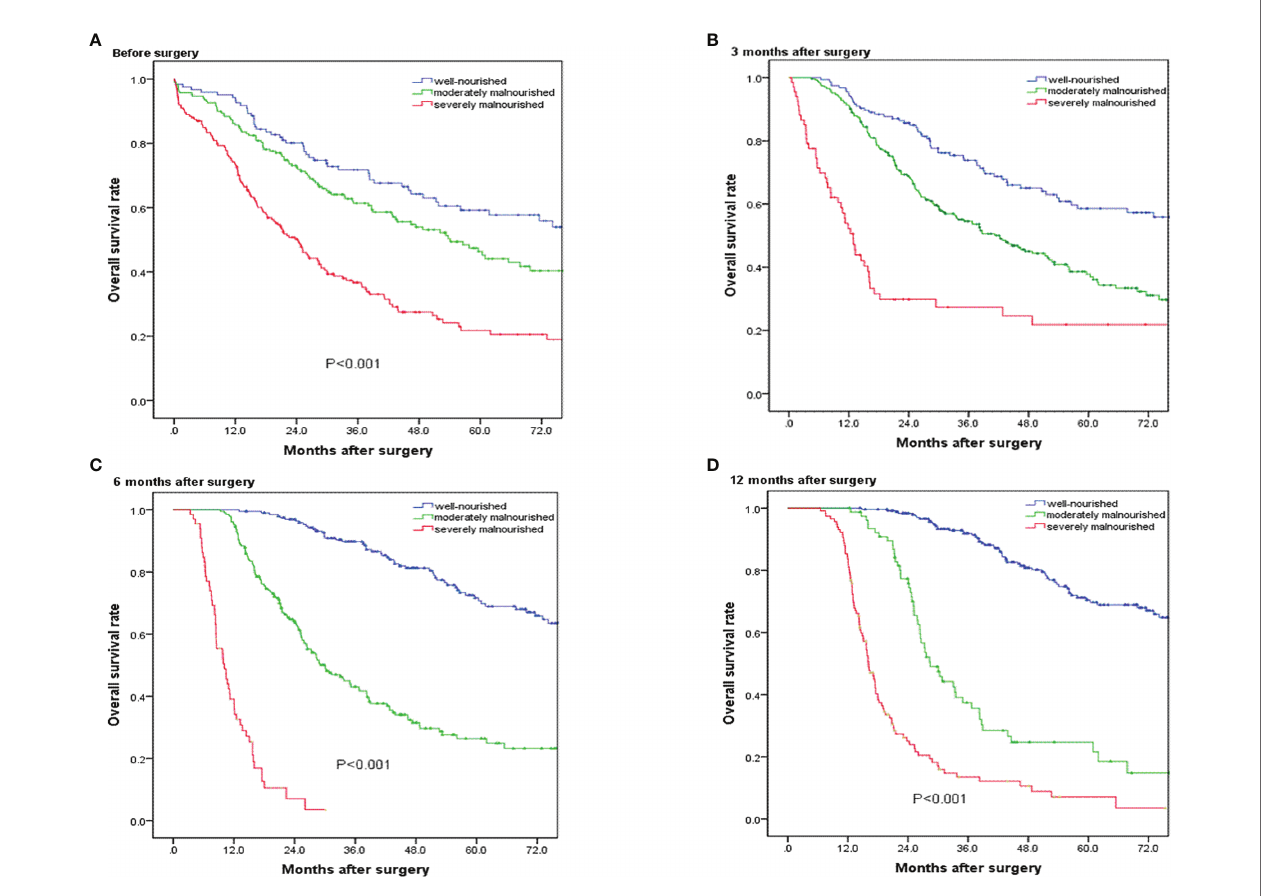
FIGURE 3 | Overall survival curves for patients in the well-nourished group, moderately malnourished group, and severely malnourished group before and at 3, 6, and 12 months after pancreatoduodenectomy. (A – D) Signi fi cant overall survival difference were observed among the three groups (p <